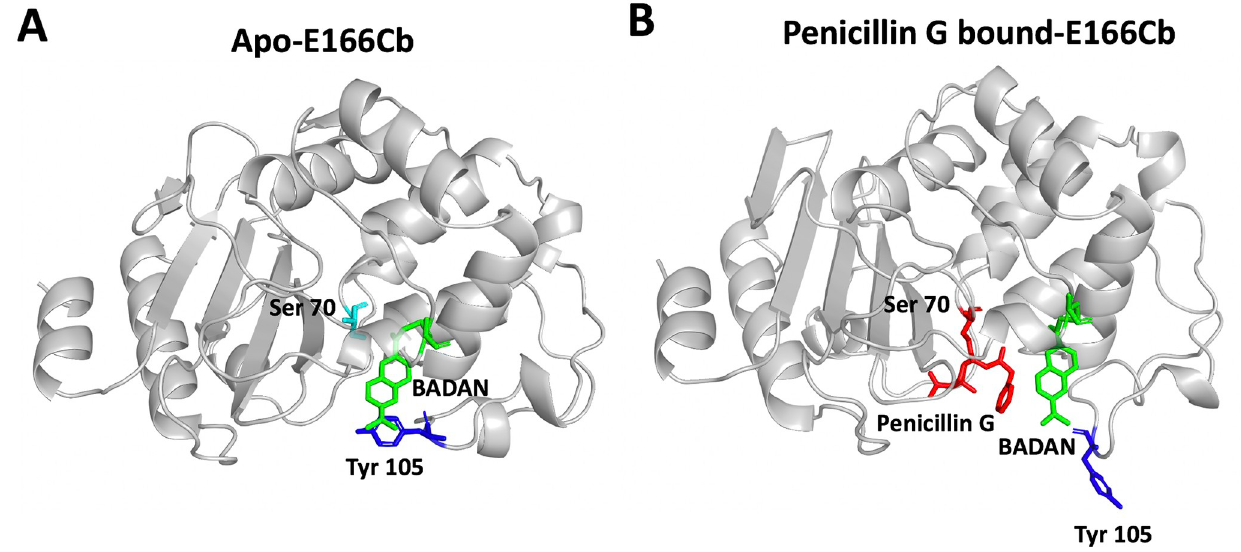
Fig 2. Models of E166Cb with and without penicillin G. (A) In the apo-E166Cb model, BADAN (green) was slightly buried in the active site pocket and stayed close to Tyr-105 (blue). Its naphthalene core was stacking on the aromatic ring of the tyrosine. (B) In the presence of penicillin G (red), BADAN moved slightly towards the aqueous environment and it was spatially separated from